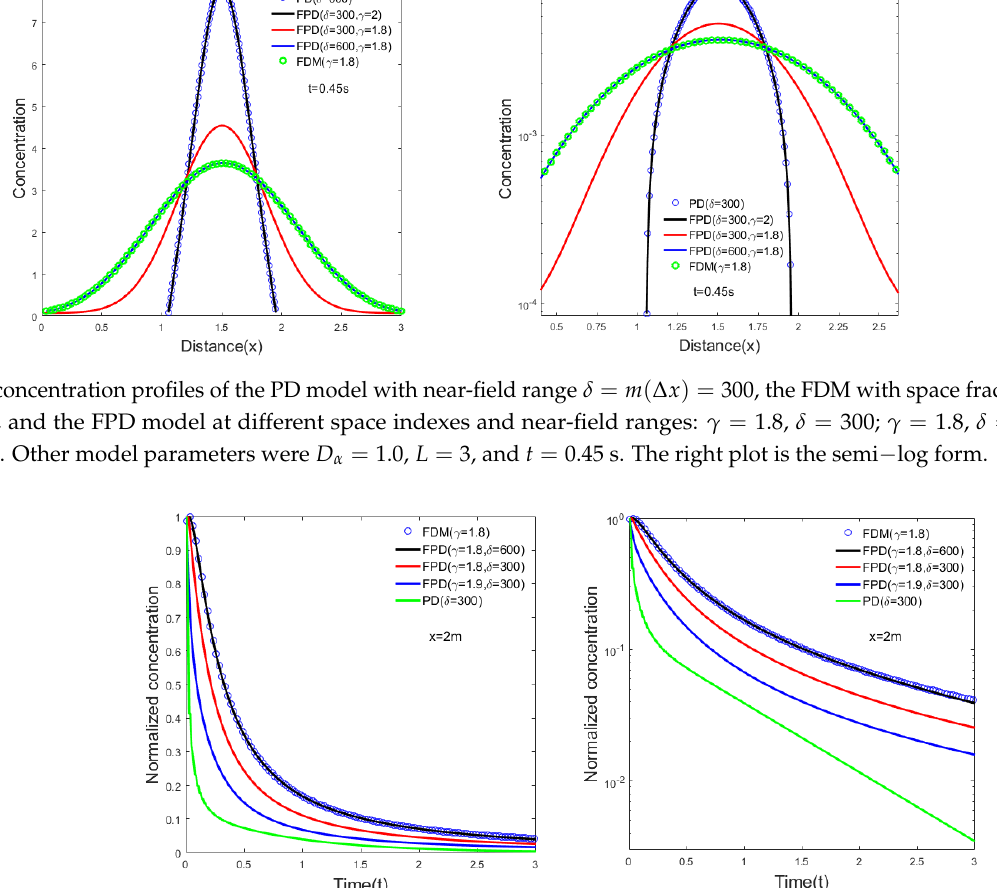
.The right plot is the semi − log form.